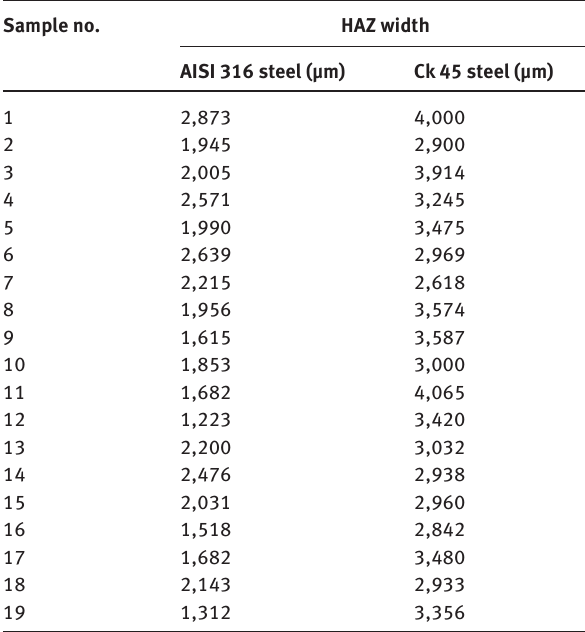
Table 4: Heat affected zone (HAZ) width of welded samples sample